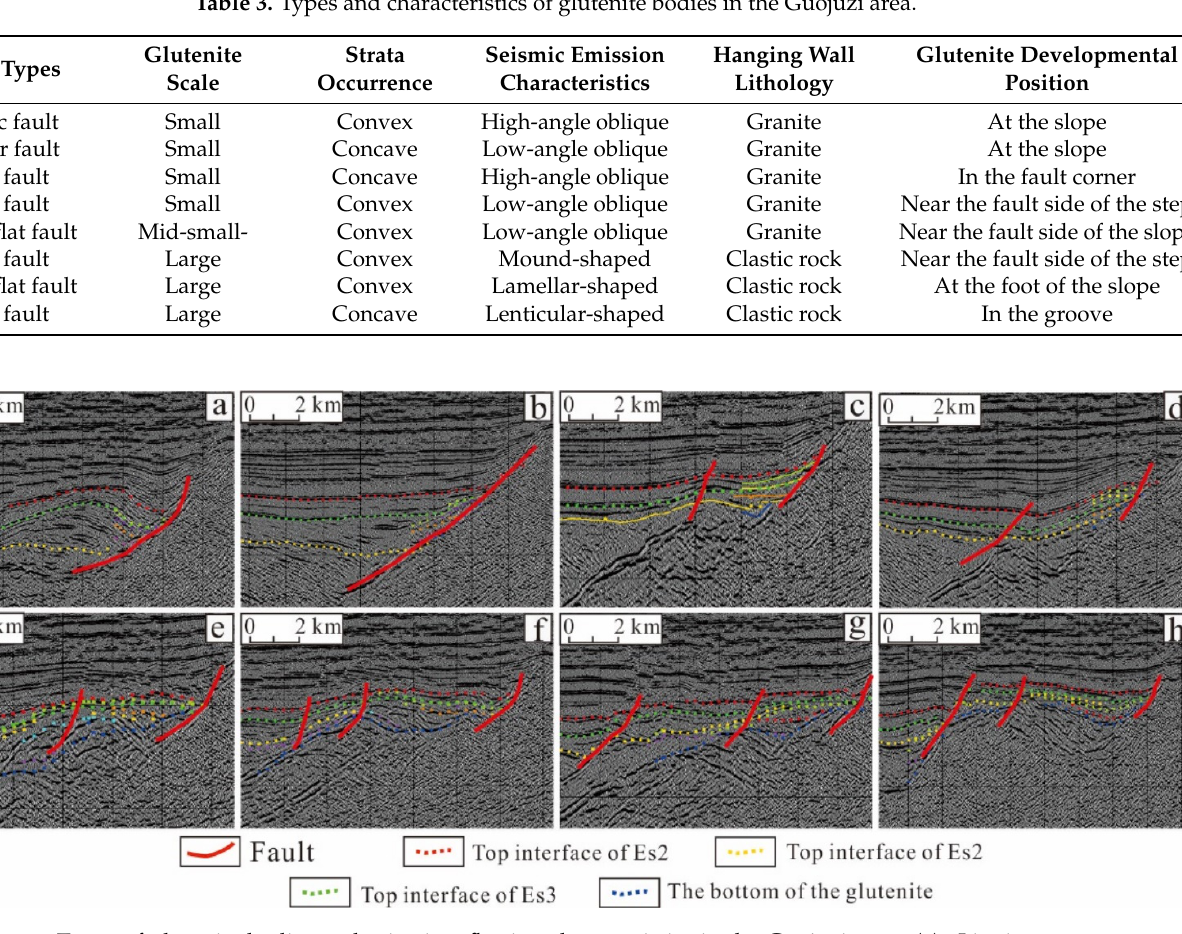
Figure 5. Types of glutenite bodies and seismic reflection characteristics in the Guojuzi area. ( a ). Listric-convex type-granite-small glutenite body; ( b ). Planar-concave type-granite-small glutenite body; ( c ). Step-concave type-granite-small glutenite body; ( d ). Step-convex type-granite-small glutenite body; ( e ). Ramp-flat-convex type-granite-small glutenite body; ( f ). Step type-convex type-clastic rock-large glutenite body; ( g ). Gentle slope type-convex type-clastic rock-large glutenite body; ( h ). Step-concave-clastic rock-large glutenite body.